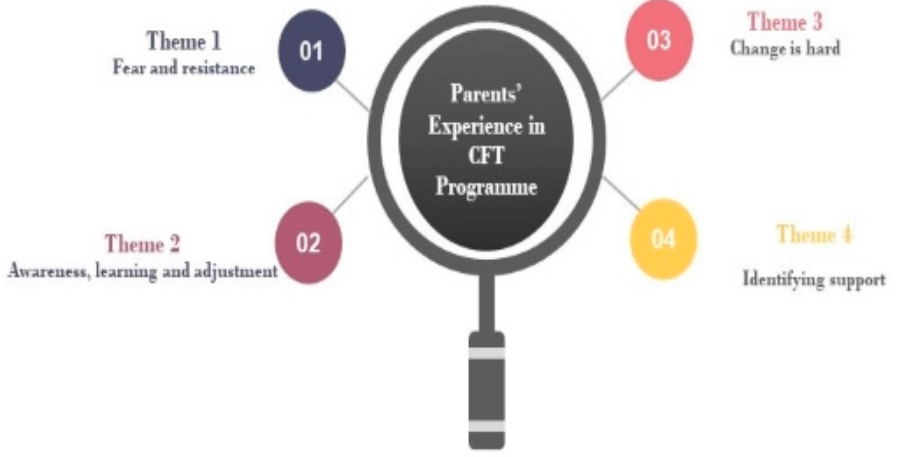
Figure 1. Parents’ experience in CFT Programme.